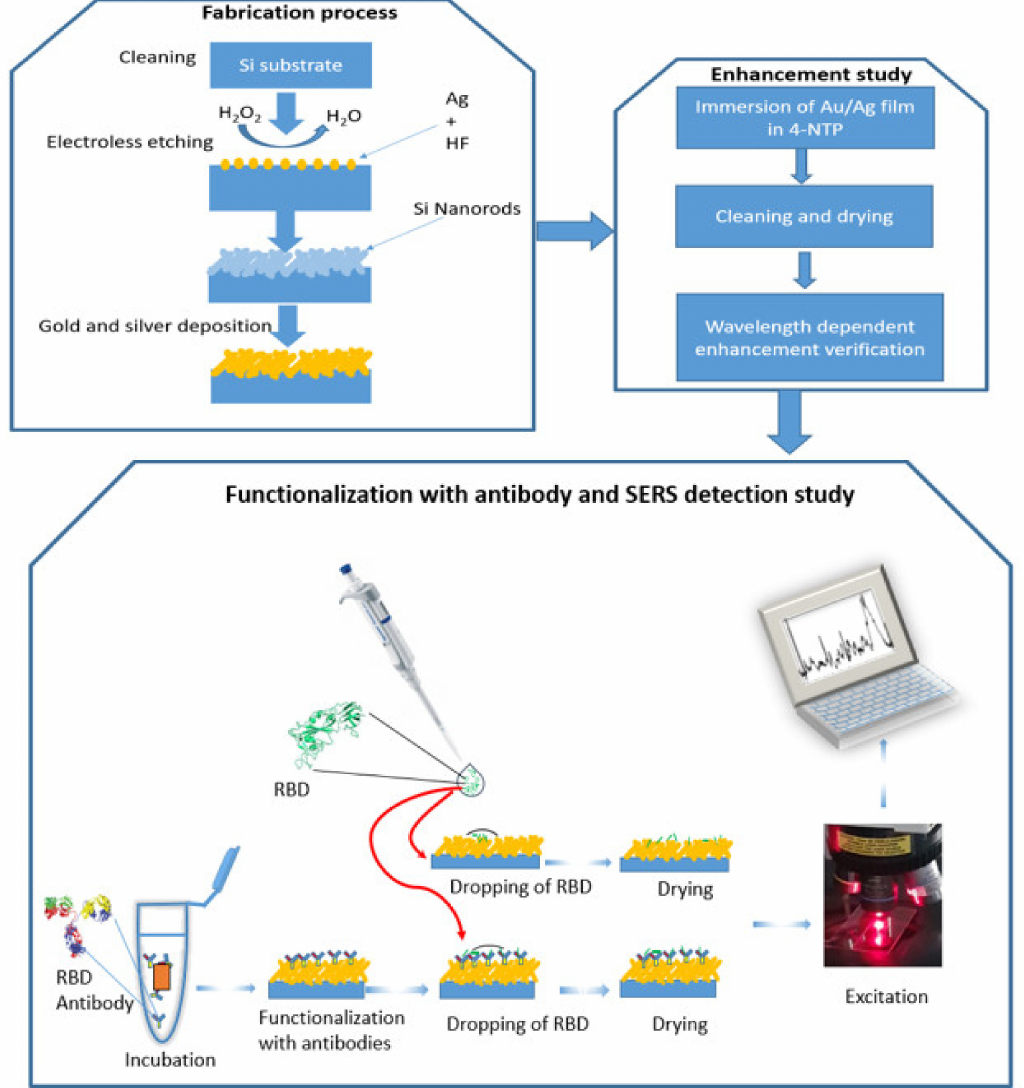
Figure 1. A schematic representation of three processes: 1—fabrication process, 2—enhancement study, and 3— functionalization with antibody and RBD detection by